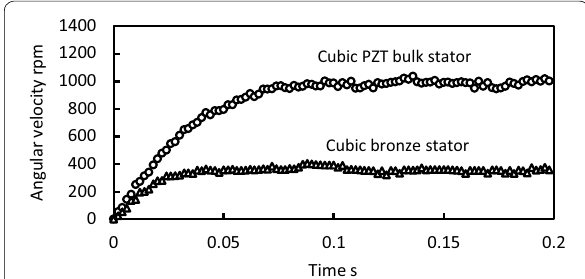
Fig. 10 Transient response of ultrasonic motors driven by the cubic bulk stator and the bronze cubic stator